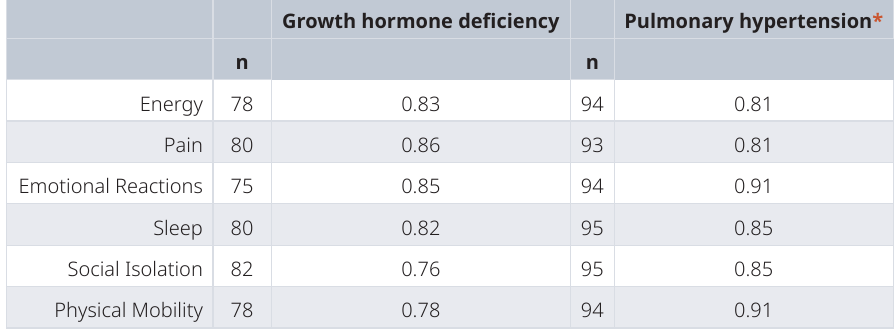
Table 4. Reproducibility (Spearman’s rank correlation coefficients) of NHP sections in adult Growth Hormone Deficiency and Pulmonary Hypertension samples.